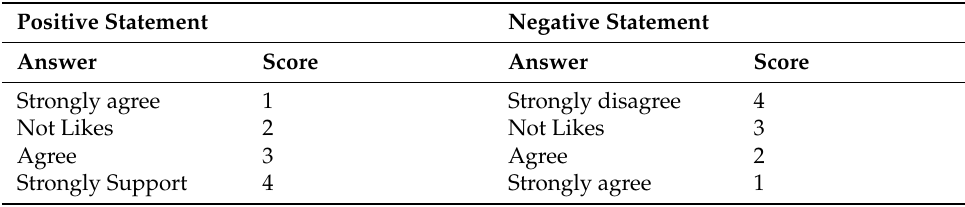
Table 2. Conversion of learning motivation questionnaire to different